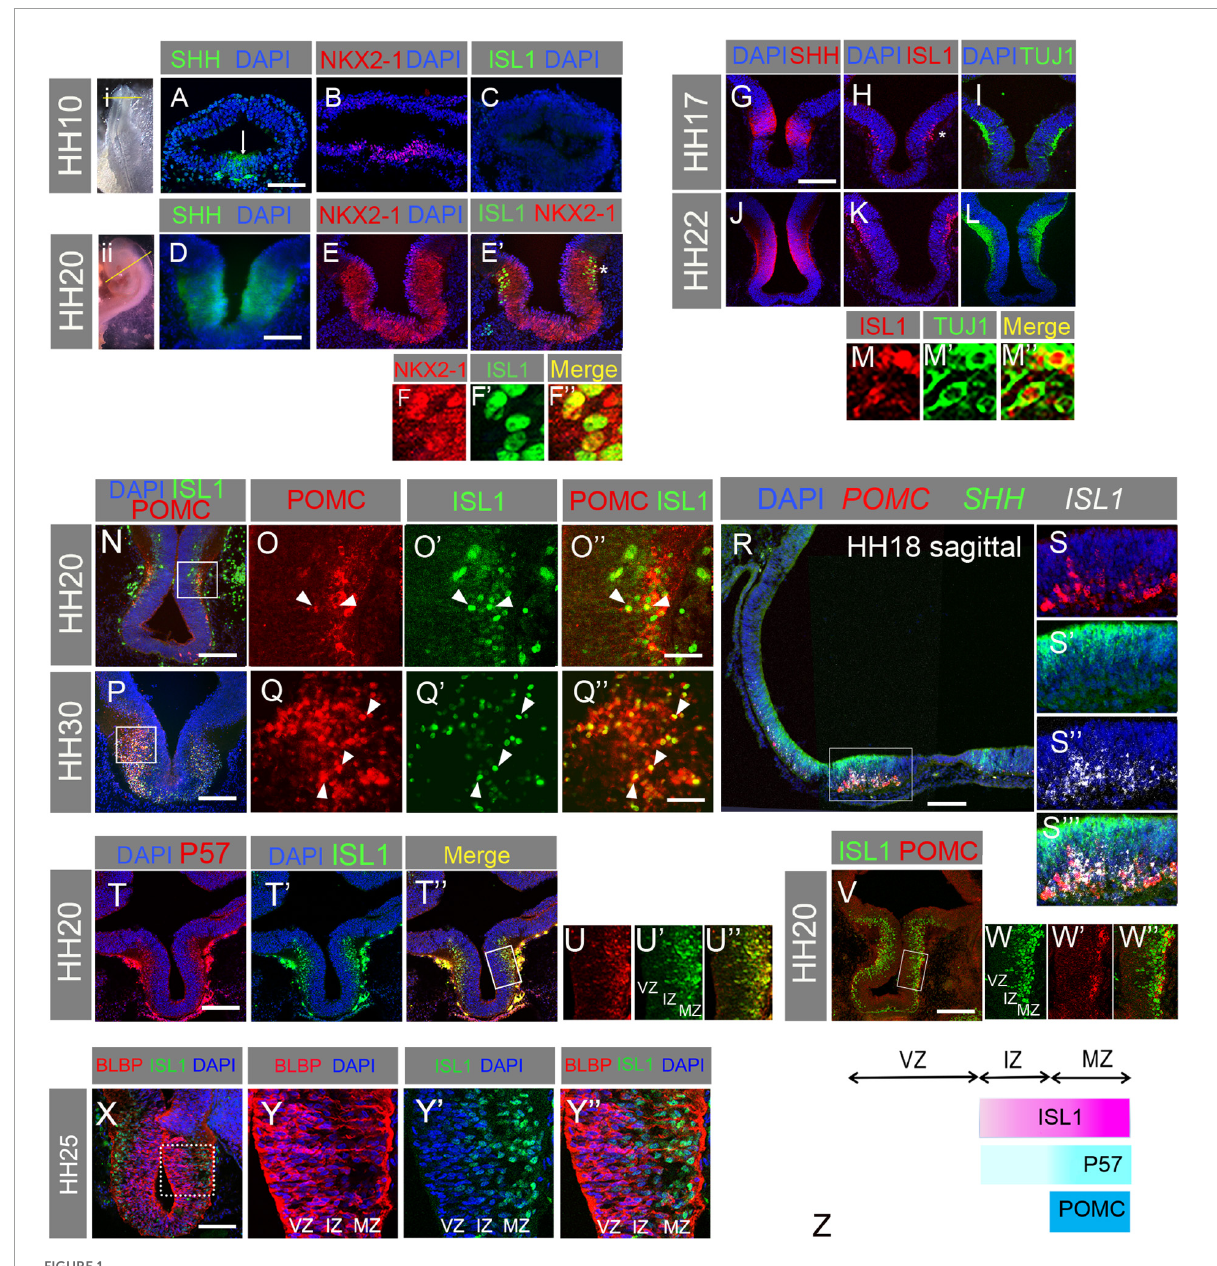
FIGURE1 (A–F”) Transverse sections of HH10 (A–C) and HH20 (D–E’) embryos through hypothalamus as indicated in whole mount (i, ii), immunolabelled for SHH, NKX2.1, and ISL1. NKX2-1/ISL1 co-expressing cells can be seen at high magnification in panels (F–F”) . Arrow = hypothalamus; * in panel (E’) marks the area shown in panel (F) . (G–M”) Transverse sections of HH17 (G–I) and HH20 (J–L) embryos through basal hypothalamus, immunolabelled for SHH (G,J) , ISL1 (H,K) , and TUJ1 (I,L) . A high magnification image was taken from an embryo double stained for ISL1 (M) and TUJ1 (M’) from the region of the hypothalamus indicated by the * in panel (H) . Co-expressing cells are observed in panel (M”) . (N–Q”) Transverse sections of HH20 (N–O”) and HH30 (P–Q”) embryos through basal hypothalamus, immunolabelled for POMC and ISL1 (N,P) . Box in panel (N) indicates region shown in panels (O–O”) . Box in panel (P) indicates region shown in panels (Q–Q”) . Arrowheads indicate co-expressing cells. (R–S”’) Sagittal section through HH18 hypothalamus processed by HCR to detect mRNA for POMC , SHH , and ISL1 . Box in panel (R) indicates region shown in panels (S–S”’) . (T–U”) Transverse sections through HH20 hypothalamus immunolabelled for P57 and ISL1. Box in panel (T”) indicates region shown in panels (U–U”) . (V–W”) Transverse sections through HH20 hypothalamus immunolabelled for ISL1 and POMC. Box in panel (V) indicates region shown in panels (W–W”) . (X–Y”) Transverse sections of HH25 hypothalamus immunolabelled for BLBP and ISL1. Box in panel (X) indicates region shown in panels (Y–Y”) . (Z) Schematic summarising the zonal locations of ISL1, P57, and POMC. VZ, ventricular zone; IZ, intermediate zone; MZ, mantle zone. Scale bars: (A) 160 µ m; (D) 80 µ m; (G) 160 µ m; (N,P) 160 µ m; (O,Q) 40 µ m; (R) 100 µ m; (T,V,X) 160 µ